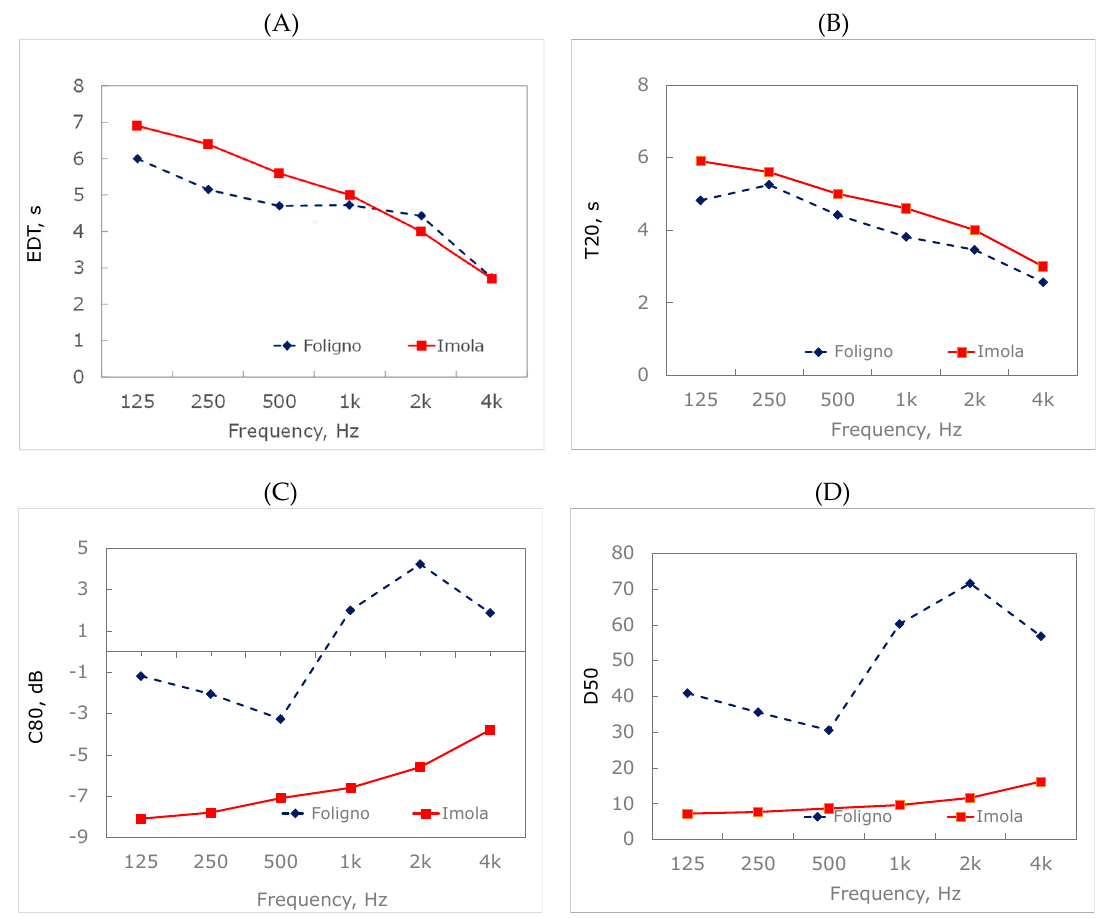
Figure 5. Measured main acoustical parameters. ( A ) EDT; ( B ) T 20 ; ( C ) C 80 ; ( D ) D 50